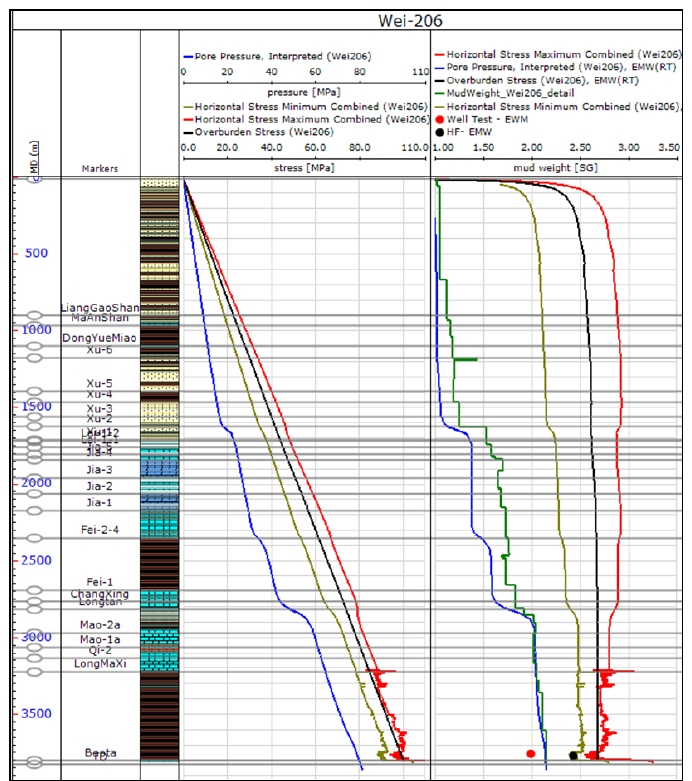
Figure 21. Final stress and pore pressure model for W206.